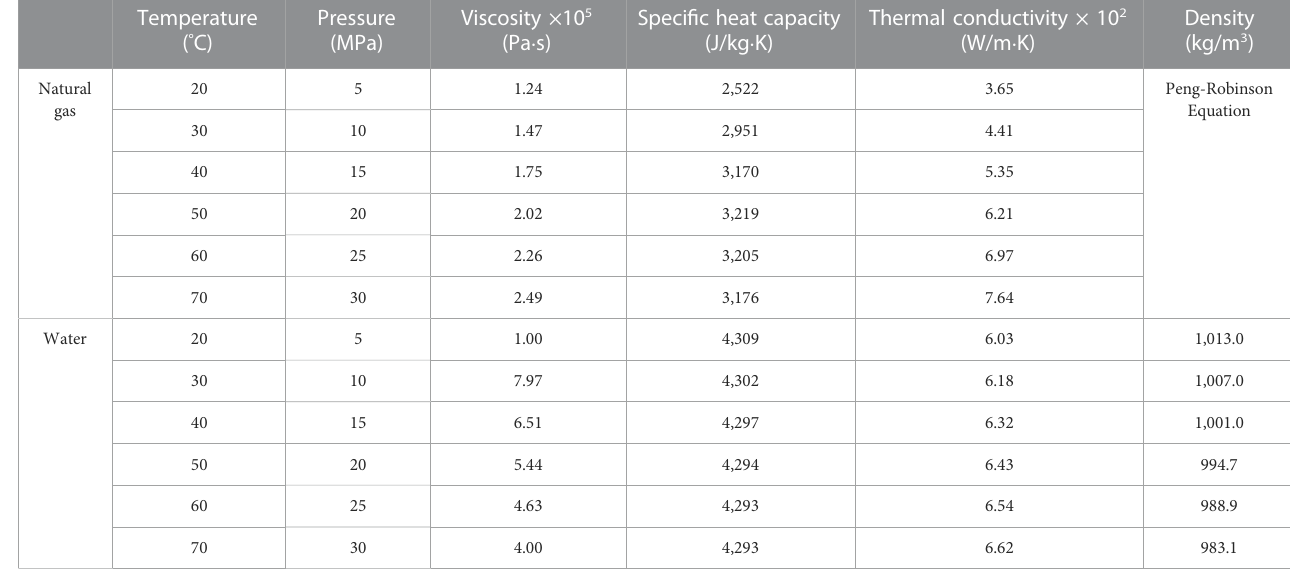
TABLE 2 Physical property parameters of natural gas and water under different temperatures and pressures. Temperature ( °